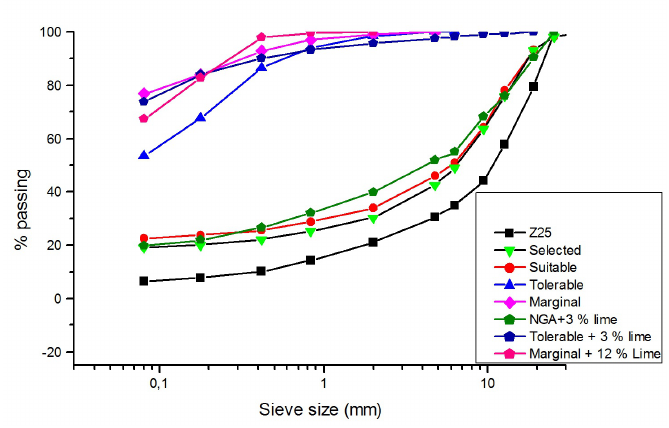
Figure 1. Grading curves of classified and stabilized